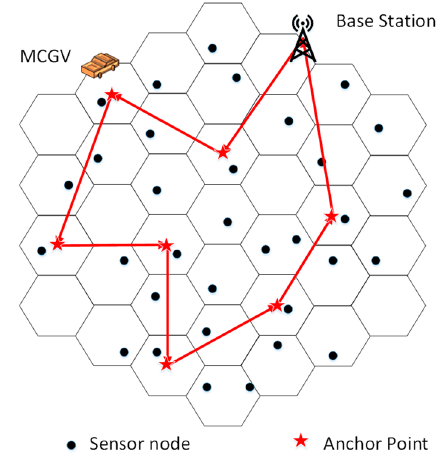
Figure 1. Example of system model with a mobile vehicle with both wireless charging and data gathering functions (MCGV).